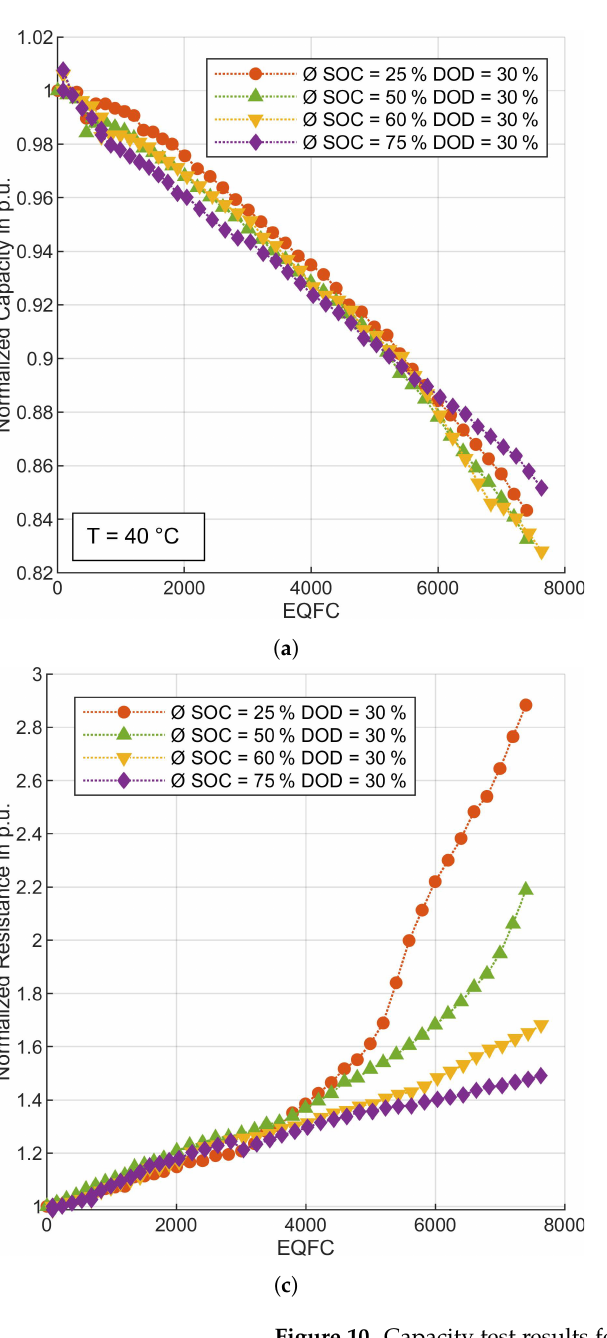
Figure 10. Capacity test results for cycle aging tests. ( a ) Capacity test results for cells cycled with 30% in the cyclic aging tests ( T = 40°C); ( b ) Capacity test results for cells cycled around 50% in the cyclic aging tests ( T = 40°C); ( c ) Inner resistance measurement results for cells cycled with 30% in the cyclic aging tests ( T = 40°C); ( d ) Inner resistance measurement results for cells cycled around 50% in the cyclic aging tests ( T =